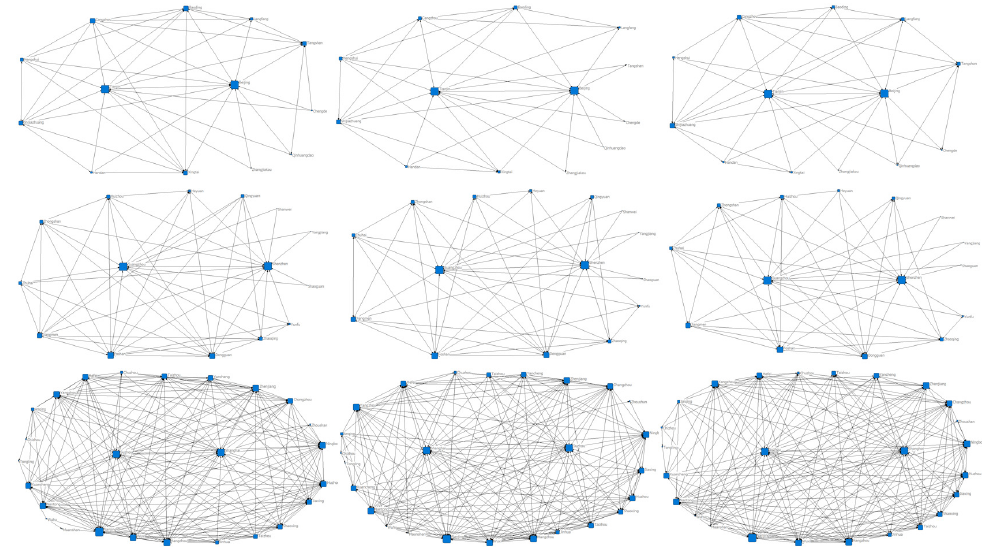
Figure 7. Network diagram of the housing prices’ association network of the BTHUR ( top ), the PRDUR ( mid ), and the YRDUR ( bottom ) in 2010, 2015, and 2020 (from left to right).